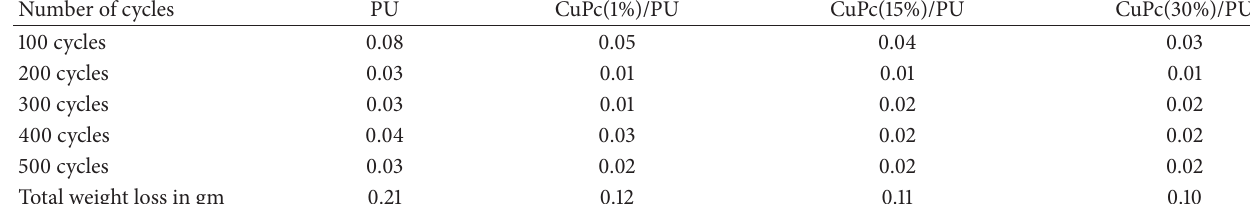
Table 1: Abrasion test results for CuPc/PU composites.